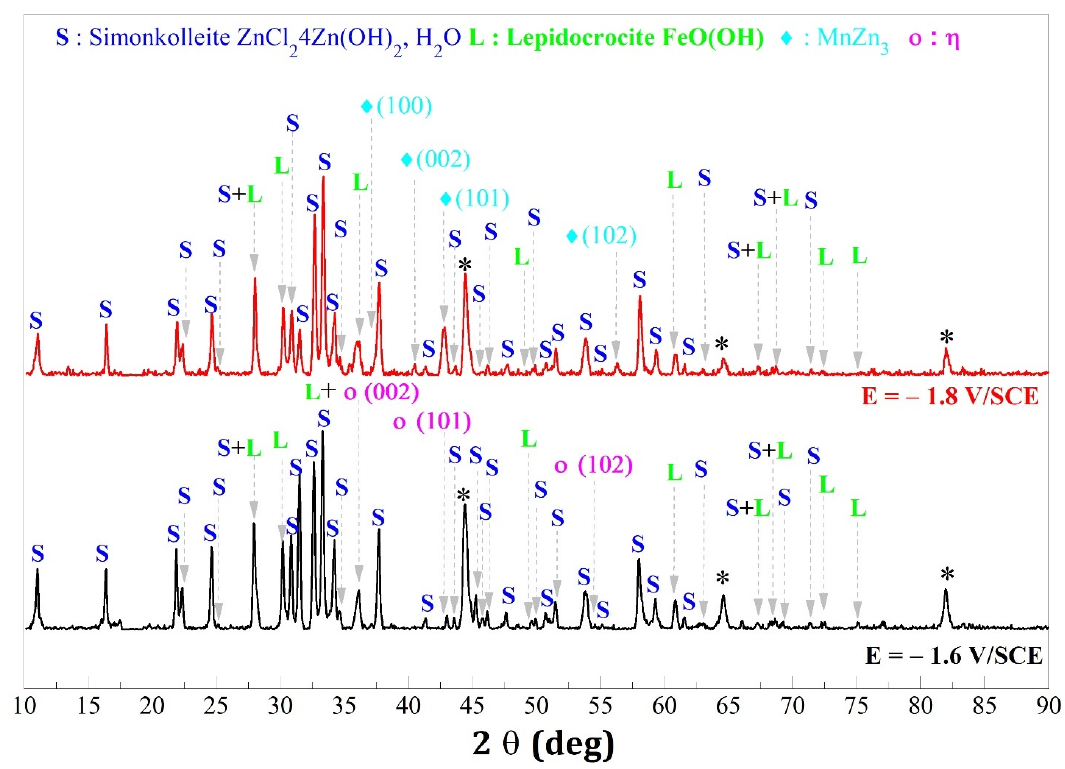
Figure 6. X-ray diffraction patterns of the deposits elaborated with and without the magnetic field and for two imposed potentials ( a ) E = − 1.6 V/SCE and ( b ) E = − 1.8 V/SCE after immersion for 48 h in 3.5% NaCl. Simonkolleite (JCPDS 00-007-0155) and lepidocrocite (JCPDS 01-074-1877). Table 2. Modeling values of Zn–Mn alloy coatings behavior in 3.5% NaCl (see Figure